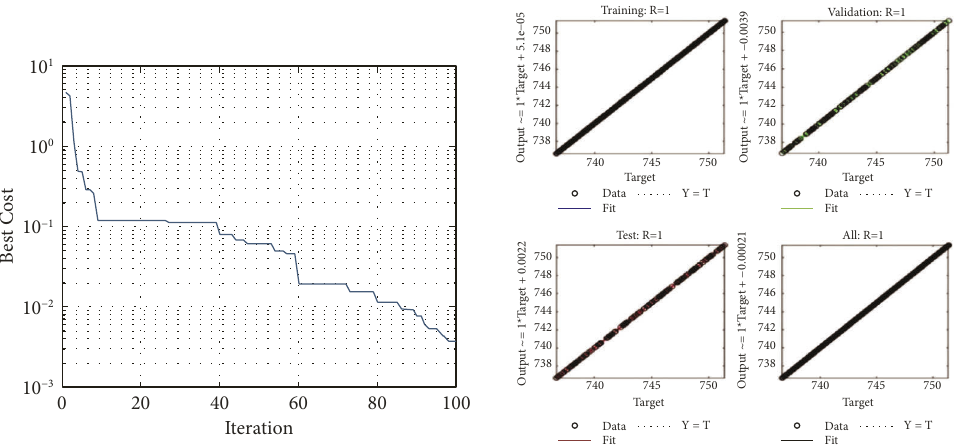
Figure 12: The best cost function for the iteration and plot regression.